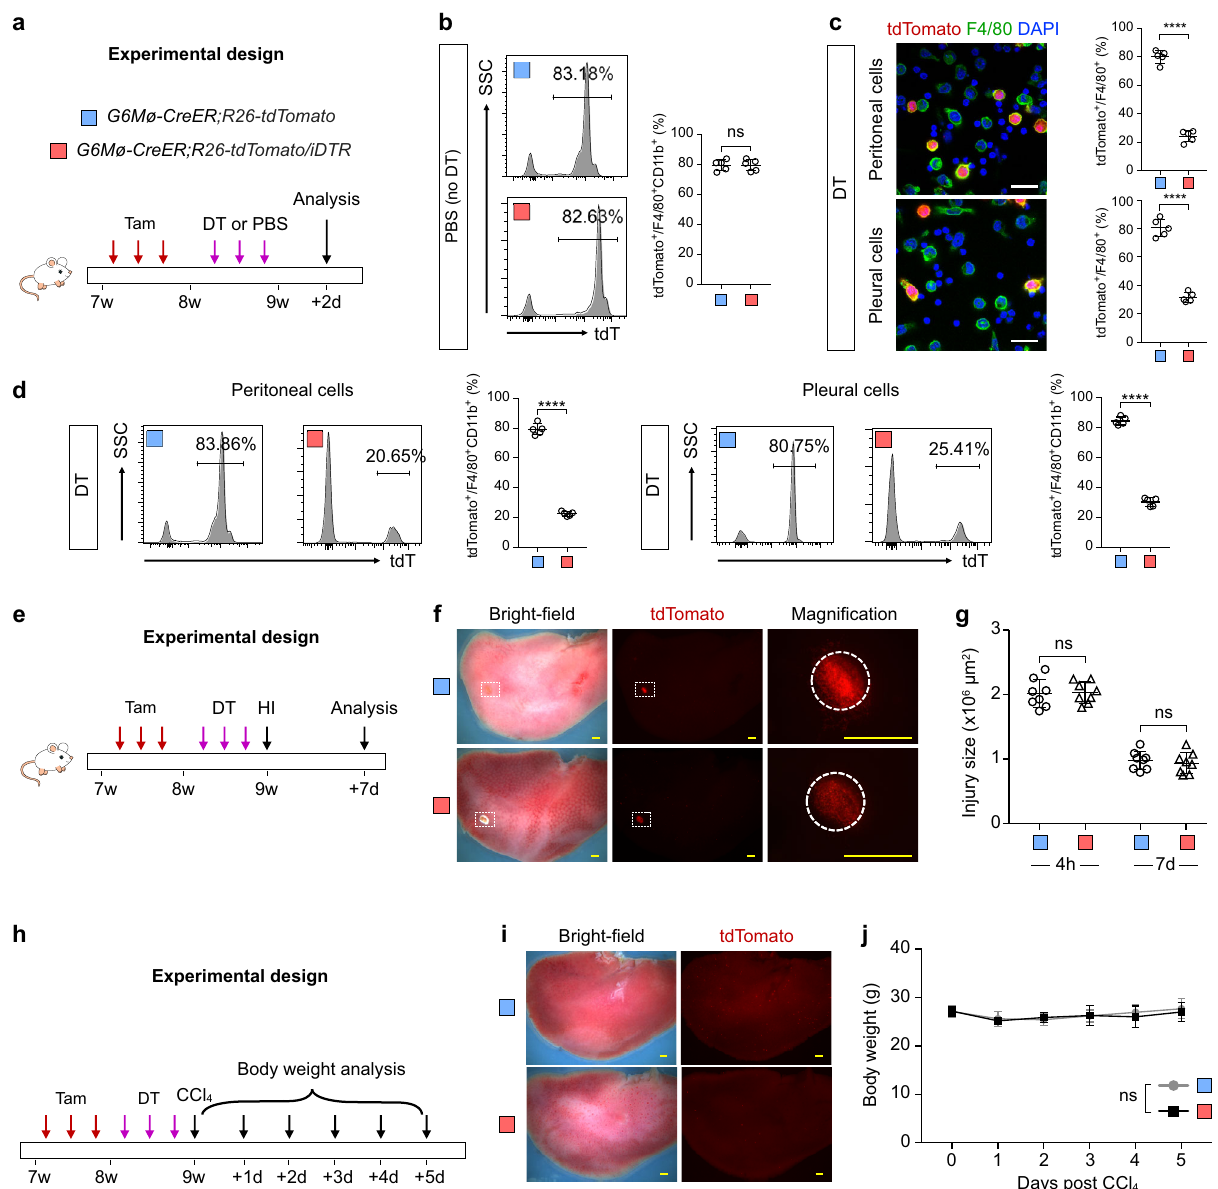
Fig. 4 Genetic ablation of cavity macrophages did not affect liver repair after injury. a Schematic fi gure showing the experimental design. DT diphtheria toxin. b Flow cytometric and quanti fi cation analysis of the percentage of CD11b + F4/80 + macrophages expressing tdTomato from peritoneal cavity after PBS treatment (no DT). Data are the mean ± SD; n = 5 mice per group; ns nonsigni fi cant. c Immunostaining for tdTomato and F4/80 on dissociated cells from the peritoneal or pleural cavity after DT treatment of the G6Mø-CreER;R26-tdTomato/iDTR mice. Quanti fi cation of the percentage of F4/80 + macrophages expressing tdTomato. Data are the mean ± SD; n = 5 mice per group; **** P < 0.0001. Each image is representative of fi ve individual biological samples. d Flow cytometric and quanti fi cation analysis of the percentage of CD11b + F4/80 + macrophages expressing tdTomato in the pleural cavity, and peritoneal cavity, respectively. Data are the mean ± SD; n = 5 mice per group; **** P < 0.0001. e Schematic fi gure showing the experimental design. HI heat injury. f Whole-mount bright- fi eld and fl uorescence images of livers at 7 days after HI. Boxed regions are magni fi ed; circles, heat injury site. Each image is representative of eight individual biological samples. g Quanti fi cation of injury size from 4 h to 7 days after heart injury. Data are the mean ± SD; n = 8 mice per group; ns nonsigni fi cant. h Schematic fi gure showing the experimental design. i Whole-mount bright- fi eld and fl uorescence images of livers at 5 days after CCl 4 treatment. Each image is representative of fi ve individual biological samples. j , Quanti fi cation of body weight at different days after CCl 4 treatment. Data are the mean ± SD; n = 5 mice per group; ns, non-signi fi cant. Scale bars: yellow, 1 mm; white, 100 µ m. P value was calculated by unpaired two-sided Student ’ s t test ( b – d , g ) or two-way ANOVA coupled with multiple comparisons ( j ). Source data are provided as a Source Data fi le. speci fi cally dissect the reparative function of GATA6 + cavity R26-tdTomato/iDTR mice did not result in any signi fi cant loss of macrophages after liver injury, we crossed G6Mø-CreER;R26- labeled cavity macrophages (Fig. 4b). When we are immunos- tdTomato with the inducible diphtheria toxin receptor (DTR) tained for tdTomato and F4/80 to identify cavity macrophages, mouse line R26-iDTR 35 to allow selective ablation of GATA6 + we found signi fi cantly lower numbers of tdTomato + macro- phages from the G6Mø-CreER;R26-tdTomato/iDTR mice com- cavity macrophages by subsequent DT treatment 36,37 (Fig. 4a). pared to the G6Mø-CreER;R26-tdTomato mice after DT Phosphate-buffered saline (PBS) injection in the G6Mø-CreER; NATURE COMMUNICATIONS| (2021) 12:2863